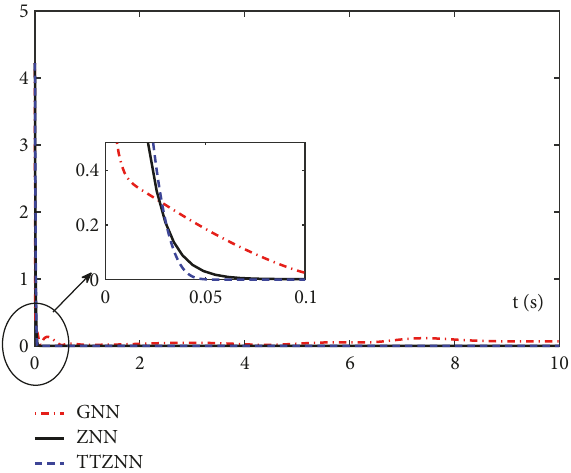
Figure 12: Residual error 𝐽 𝐸 with different neural networks under the kinematic repeatable scheme